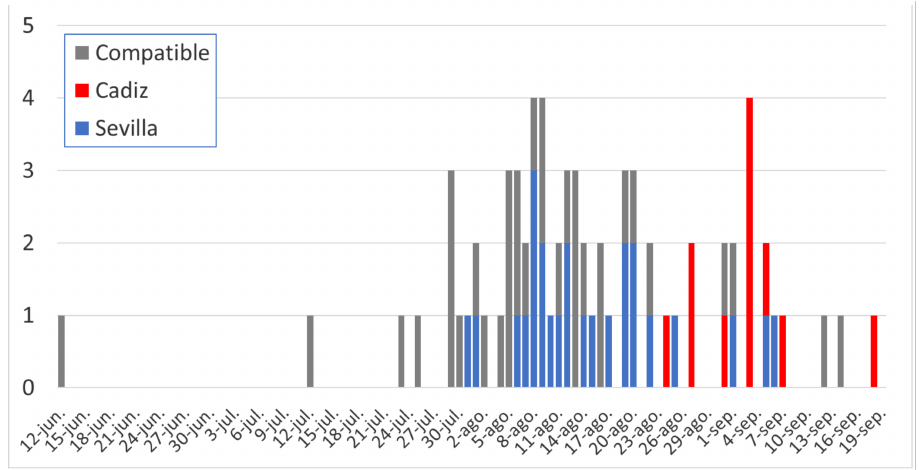
Figure 1. Epidemic curve of confirmed cases of WNV meningoencephalitis, by province of exposure (blue, Sevilla; red, C á diz), as well as probable WNV cases detected by retrospective analysis